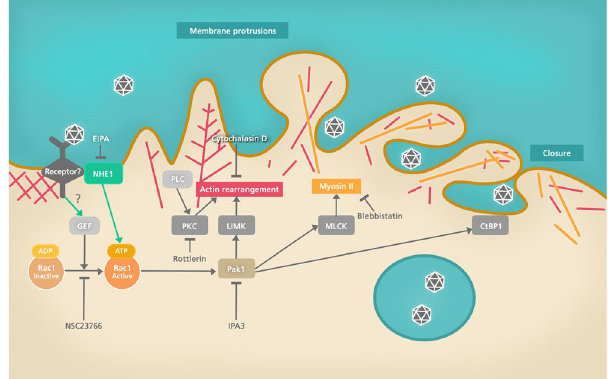
Figure 10. Cellular factors possibly involved in IPNV macropinocytosis. The scheme shows a commonly found factors associated to macropinocytosis pathways. Inhibition of the Rho GTPase Rac1, Pak1, PKC, myosin II and NHE1 affected IPNV infection. Inhibition sites of the drugs and efector proteins (MLCK, LIMK, CtBP1) are shown. MLCK: myosin light chain kinase, LIMK: LIM kinase, CtBP1: C-terminal binding protein